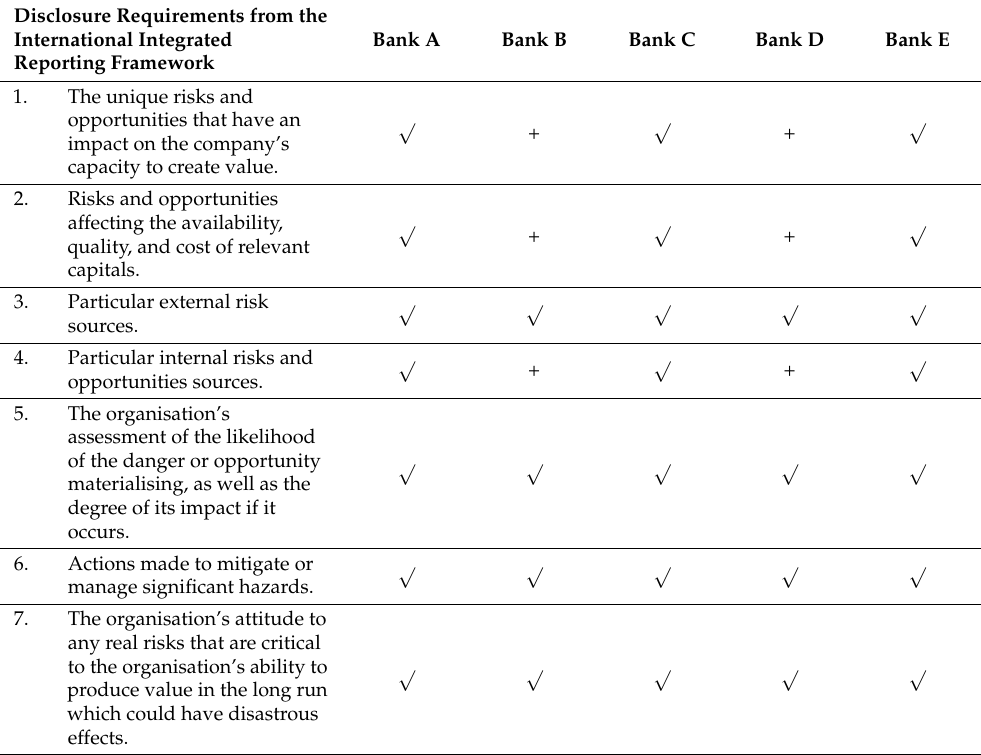
Table 1. Disclosures of Risk and Opportunity in the Integrated